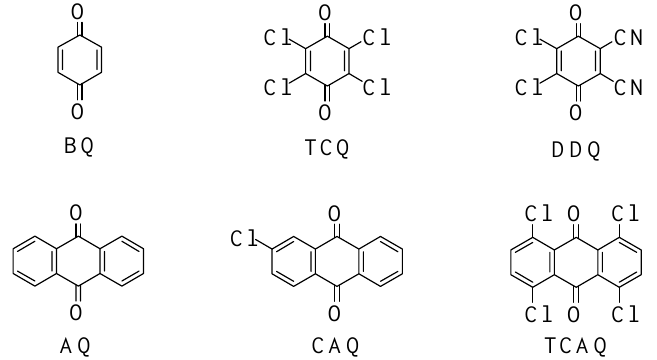
Figure 1 . The studied benzoquinones and anthraquinones.